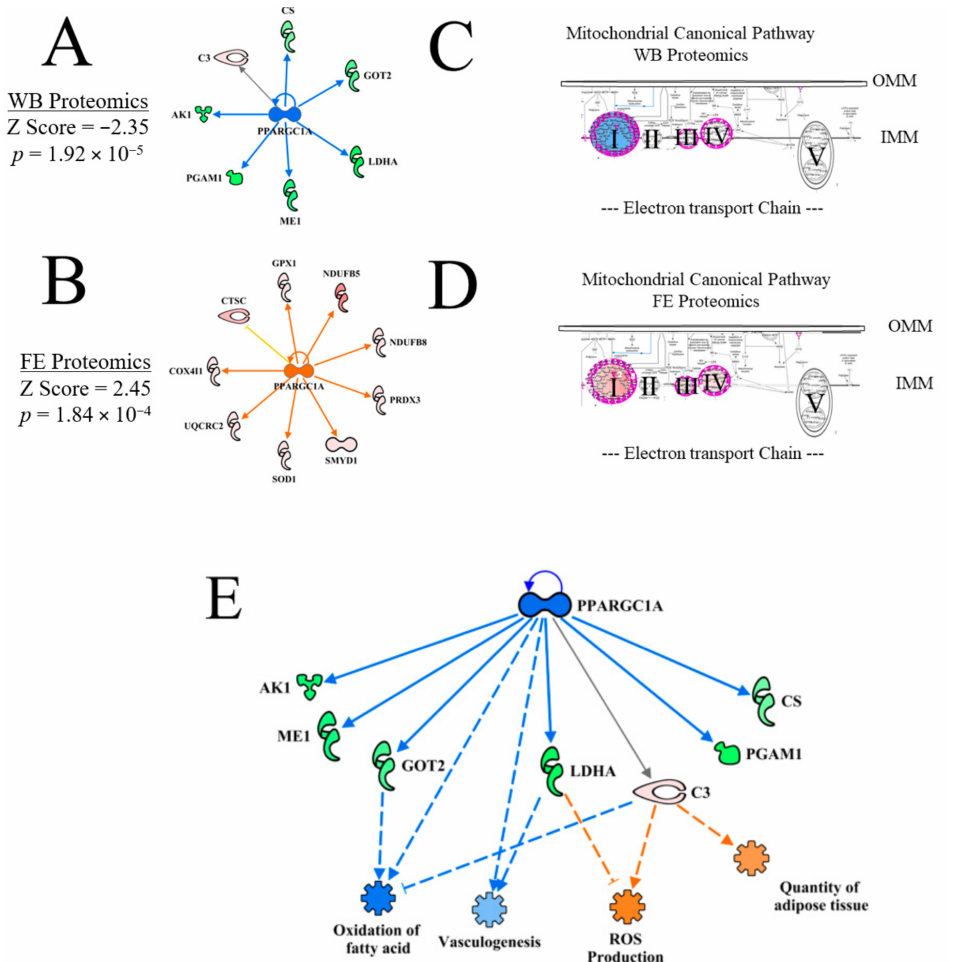
Figure 10. The upstream regulator network for PPARGC1 α for WB myopathy vs. control breast muscle in commercial broilers ( A ) and high vs. low FE PedM ( B ) proteomic datasets [11]. The predicted inhibition of PGC1 α in WB myopathy was associated with the predicted inhibition of Complex I of the mitochondrial electron transport chain in WB myopathy ( C ), whereas the predicted activation of PGC1 α in high FE was associated with predicted activations of Complex I, III and IV of the mitochondrial electron transport chain ( D ). The regulatory network for PPARGC1A showing the downstream target molecules involved in the predictions of inhibition of vasculogenesis and oxidation of fatty acid and activation of reactive oxygen species (ROS) production and quantity of adipose tissue ( E ). Protein abbreviations in ( A , E ) are defined and differential expression of proteins are provided in Supplementary Table S1. Protein abbreviations for ( D ) are as follows: COX4I1 (cytochrome oxidase subunit IV isoform 1), CTSC (cathepsin C), GPX1 (glutathione peroxidase 1), NDUFB5 (NADH dehydrogenase (ubiquinone) Complex I assembly factor 5), NDUFB8 (NADH dehydrogenase (ubiquinone) beta subcomplex, 8), OMM (Outer Mitochondrial Membrane), IMM (Inner Mitochondrial